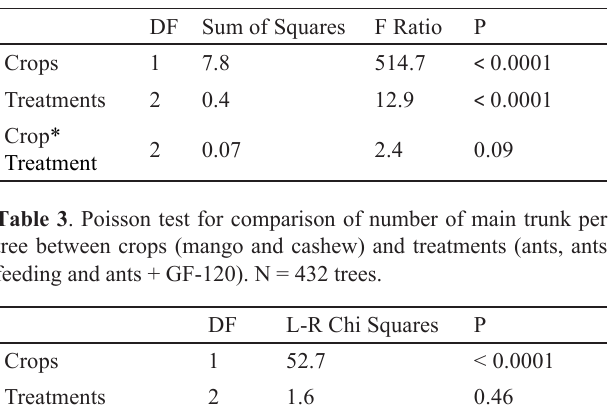
Table 2 . Two ways ANOVA comparing the mean number of weaver ant nests per tree between crops (mango and cashew) and treatments (ants, ants feeding and ants + GF-120). N = 432 trees.